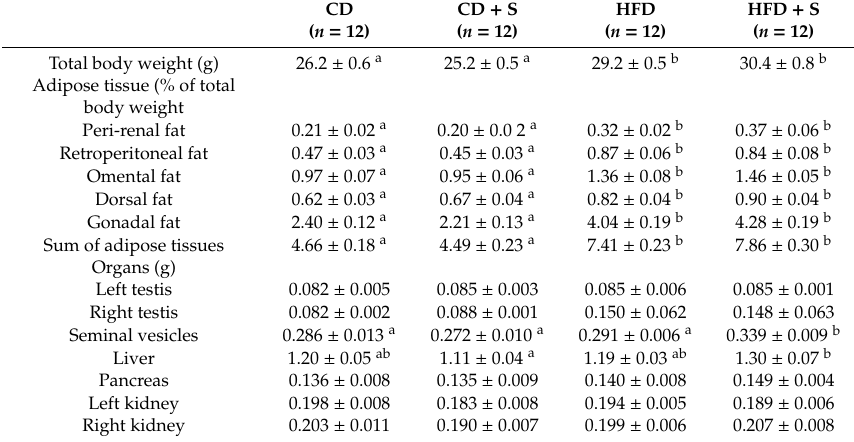
Table 2. The e ff ect of diet and short-term micronutrient supplementation on body composition at post